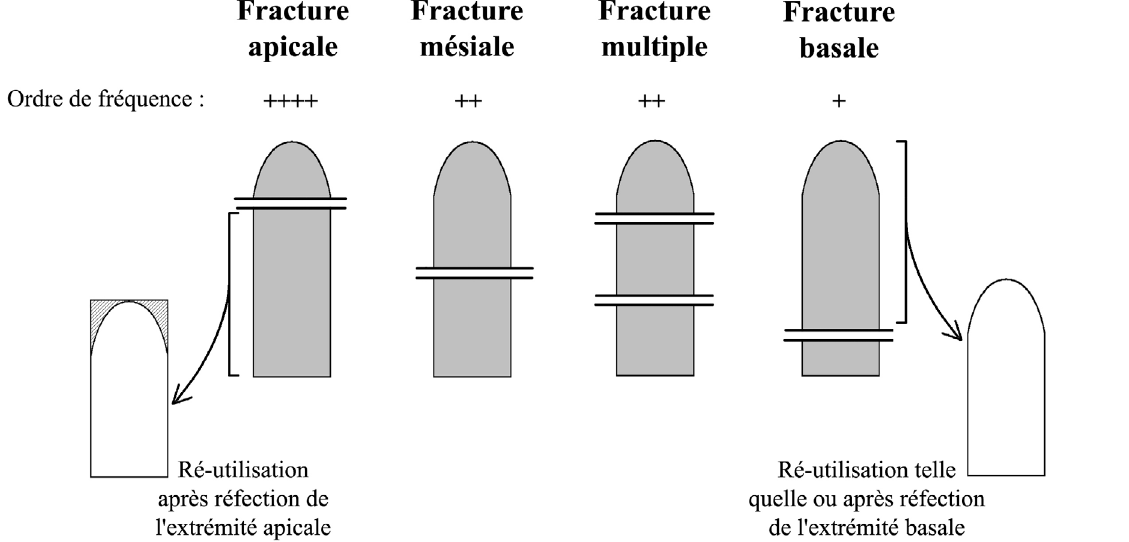
Figure 7. Les principaux schémas de fracturation des pièces façonnées unifacialement à GO-JA-01 et leur ordre de fréquence. Figure 7. Frequencies of the main fracturing schemes of unifacially shaped artefacts from GO-JA-01